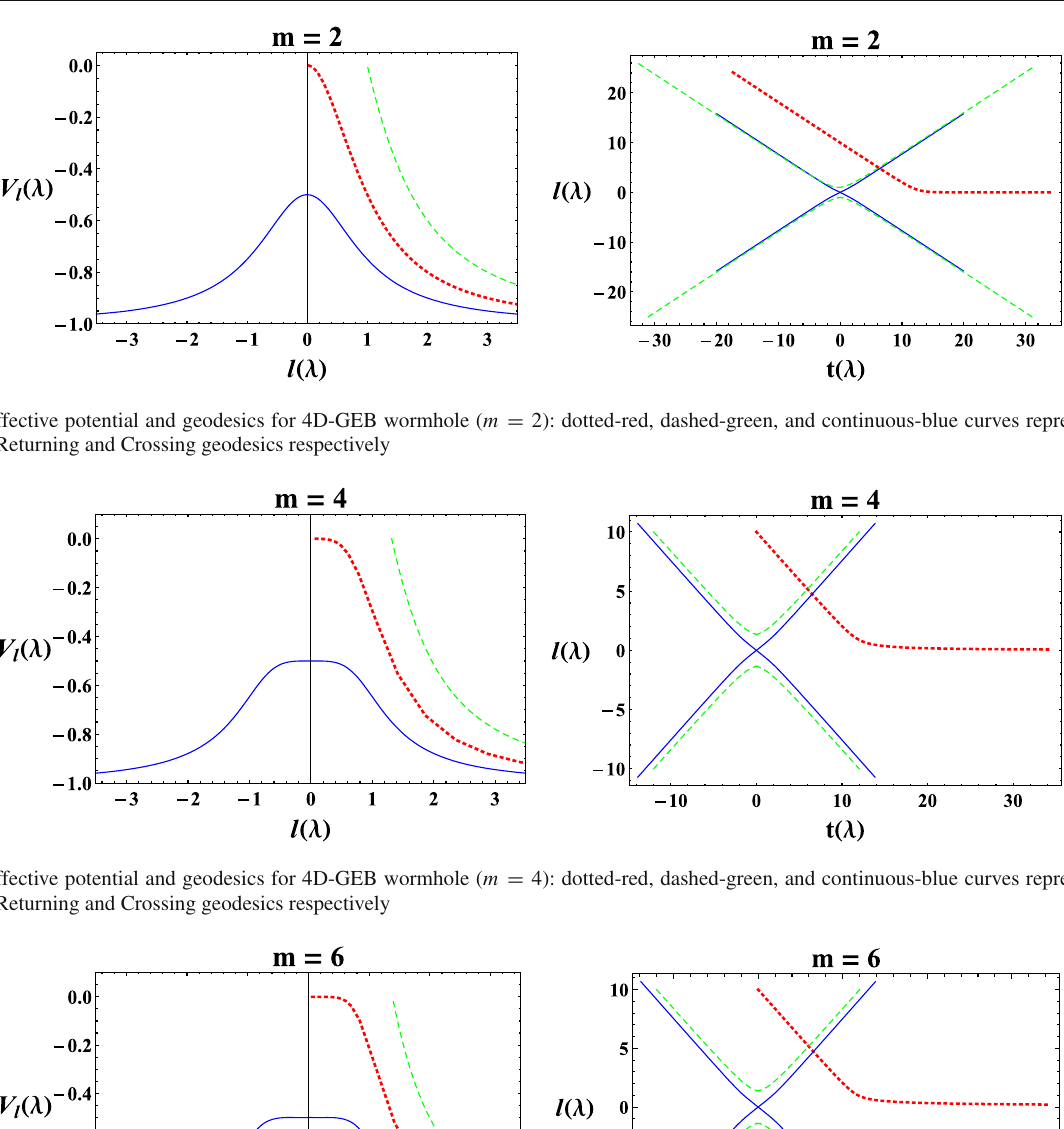
tories corresponding to y ( 0 ) = 0 for both types of warp factors. Remarkably only returning and crossing trajectories exist corresponding to all other y ( 0 ) values for growing